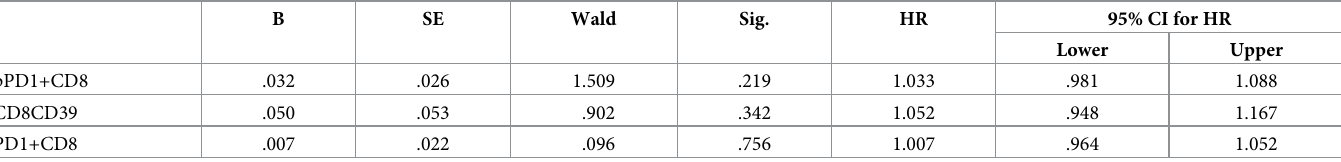
Table 6. Cox regression analysis of DFS of 30 females with TNBC.